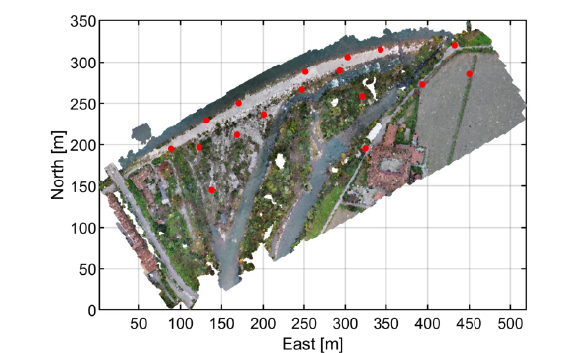
Figure 1. Point cloud of the Cassano d’Adda case study. The red dots show the location of GCPs.